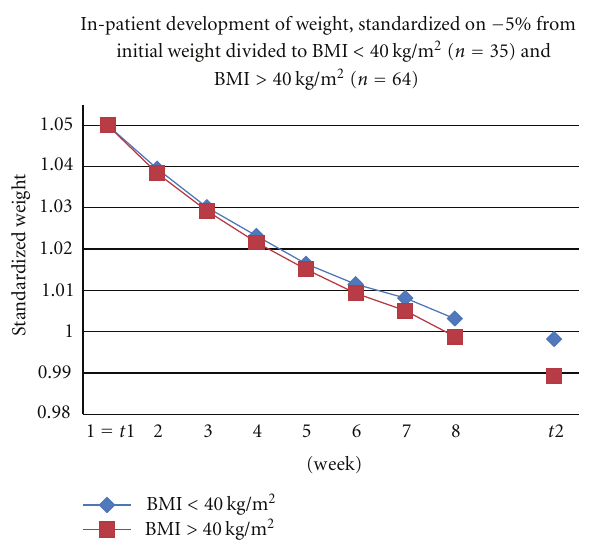
Figure 1: In-patient body weight of the subgroups BMI ≶ 40 kg/m 2 .